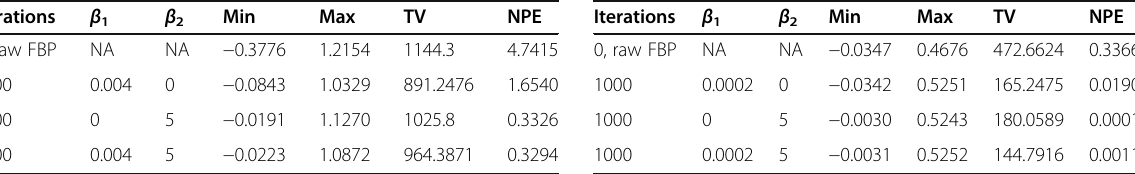
Table 3 Values of maximum, minimum, metal-free region TV, and NPE in reconstructions of bag #3